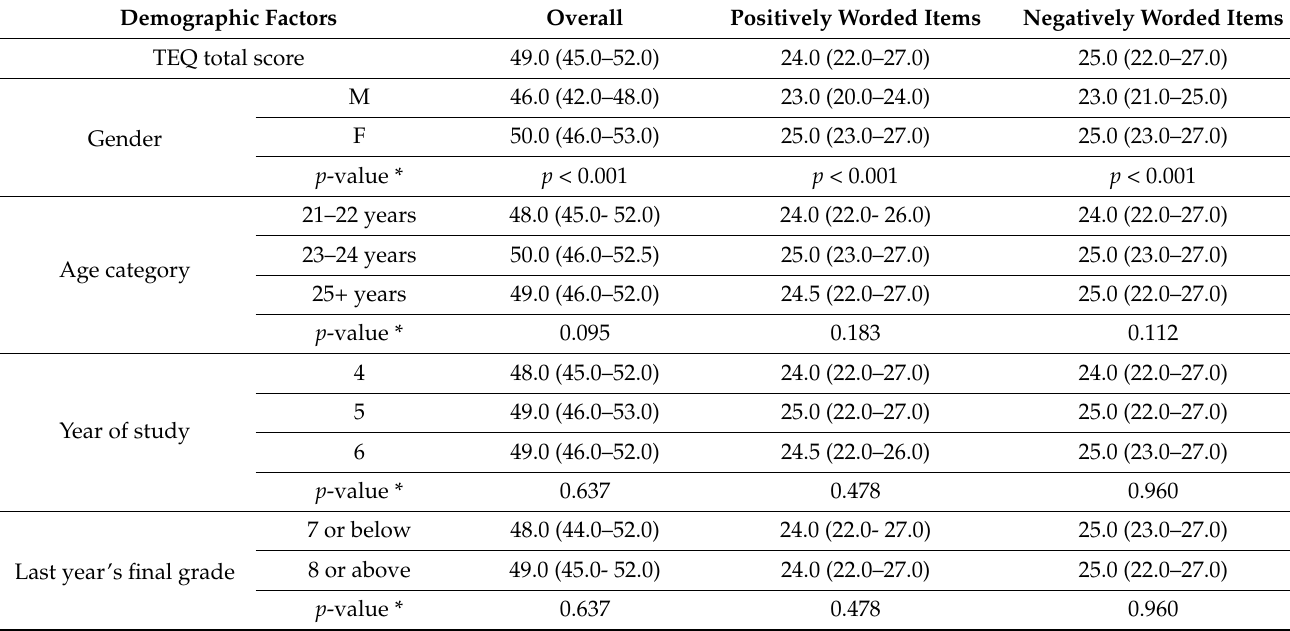
Table 3. Total, positive, and negative total scores per demographic factors ( n =